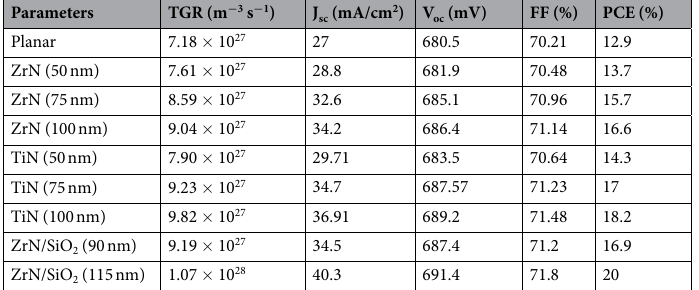
Table 4. Comparison of optical and electrical parameters upon the use of different